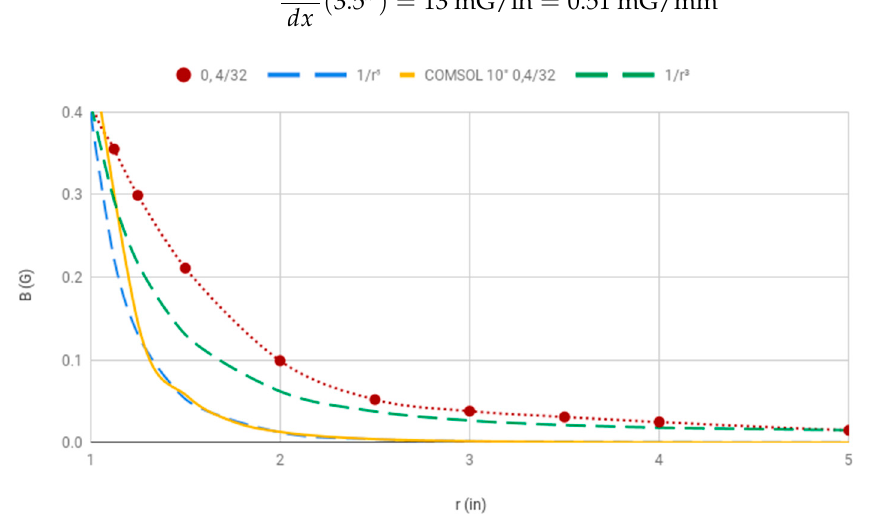
Figure 13. Far-field asymptotic behavior, 1/r 5 (blue broken line), and 1/r 3 (green broken line).